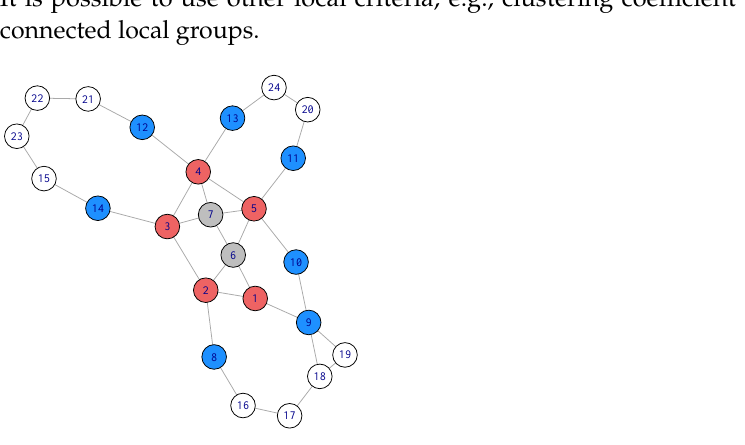
Figure 1. In an intermediate step, the current local community C consists of vertices 1 through 7, in which vertices 1 through 5 (red color) are boundary B . Vertices 6 and 7 (gray color) are the interior of C . The neighbor set U includes vertex 8 through 14 (blue color). The remaining vertices in the network are in